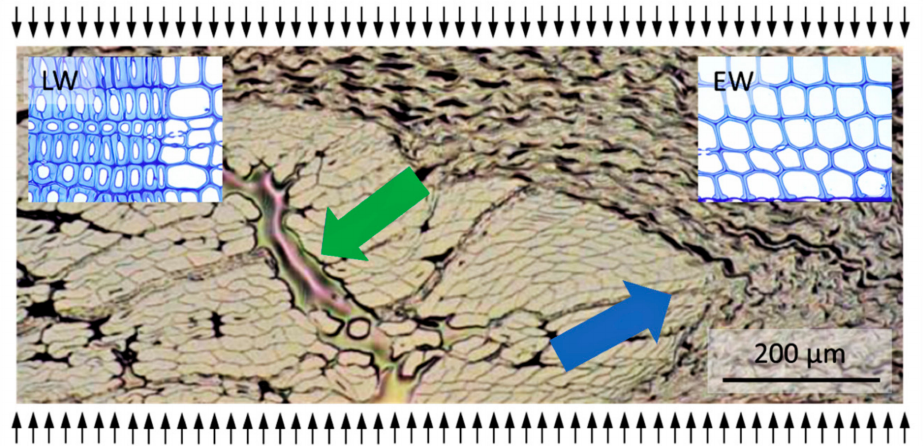
Figure 4. Light microscopy of partially delignified and densified wood showing latewood buckling (blue arrow) and microscopic internal cracks (green arrow) due to compression in the tangential direction (upper and bottom arrows). The inserts show representative examples for the appearance of untreated latewood (LW) and earlywood